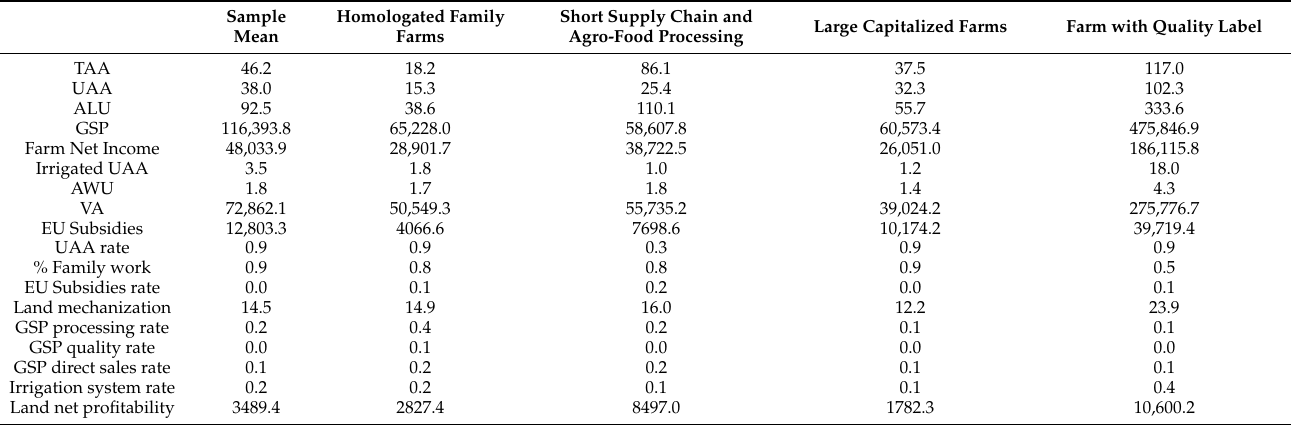
Table A3. Description of the average values of the main structural variables and of the main indexes by cluster identified in the center geographical breakdown